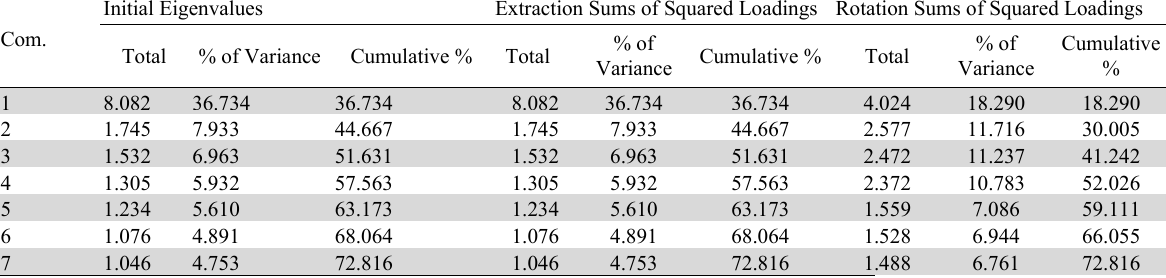
The result of extracted variance analysis of influencing factors group Initial Eigenvalues Com.